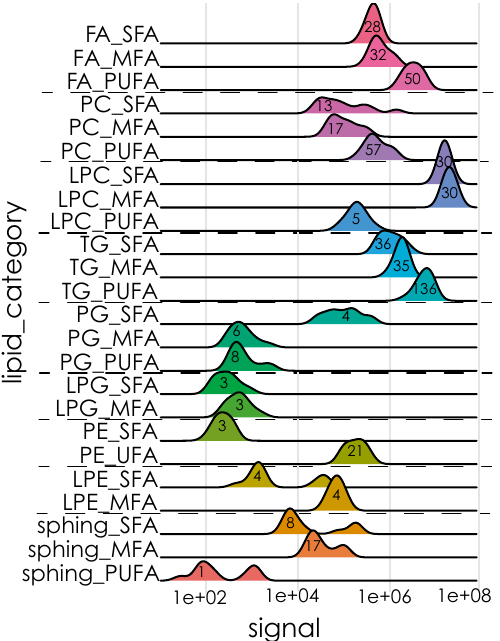
Figure 3. Signal of different lipid categories . The log signal of saturated fatty acids (SFA), monounsaturated fatty acids (MFA), or polyunsaturated fatty acids (PUFA), free fatty acids (FFA), phosphatidylcholines (PC), lysophosphatidylcholines (LPC), triacylglycerides (TG), phosphatidylglycerols (PG), lysophosphatidylglycerols (LPG), phosphatidylethanolamines (PE) and lysophosphatidylethanolamines (LPE), sphingolipids and glycosphingolipids. In each peak the number of detected lipids is